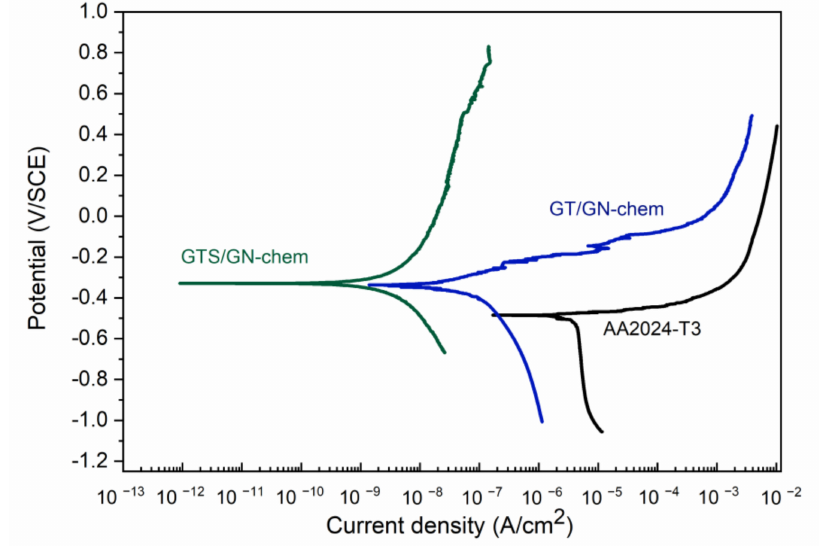
Figure 5. Potentiodynamic polarization curves of bare AA2024-T3 and substrates coated with hybrid sol–gel coatings including chemically modified graphene